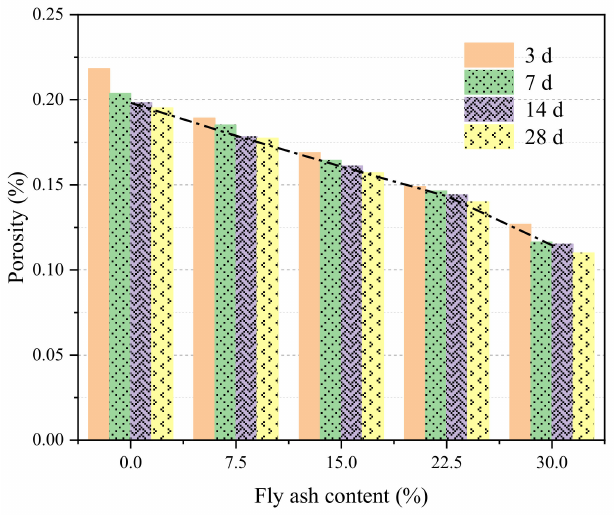
Figure 7. Mean porosity of the backfill with each ratio in different curing